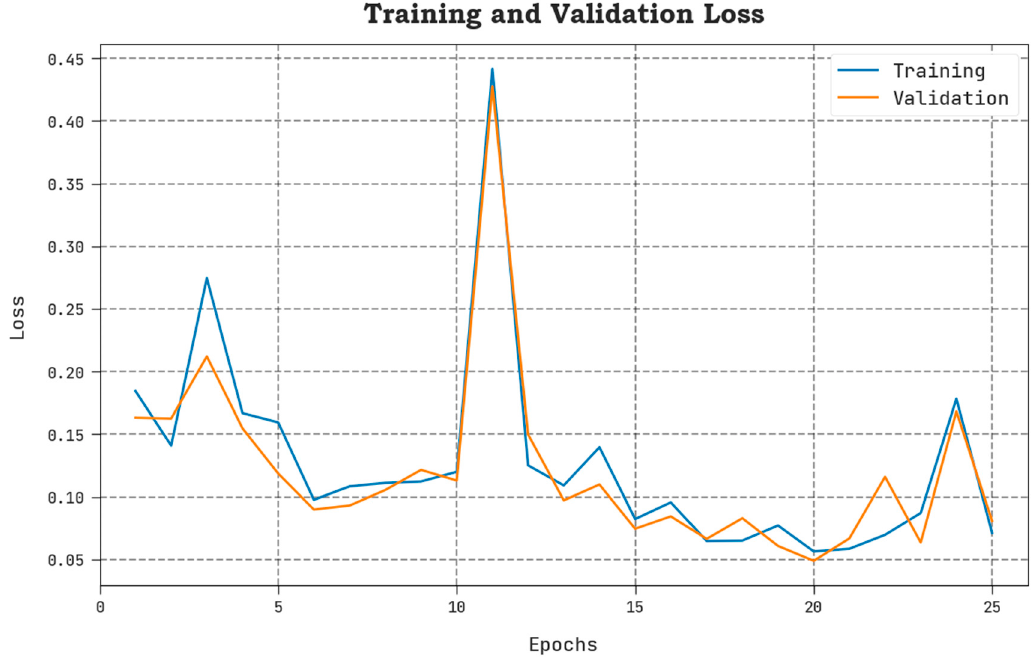
Figure 12. TLOS and VLOS analysis of AAOXAI-CD method on dataset-2.